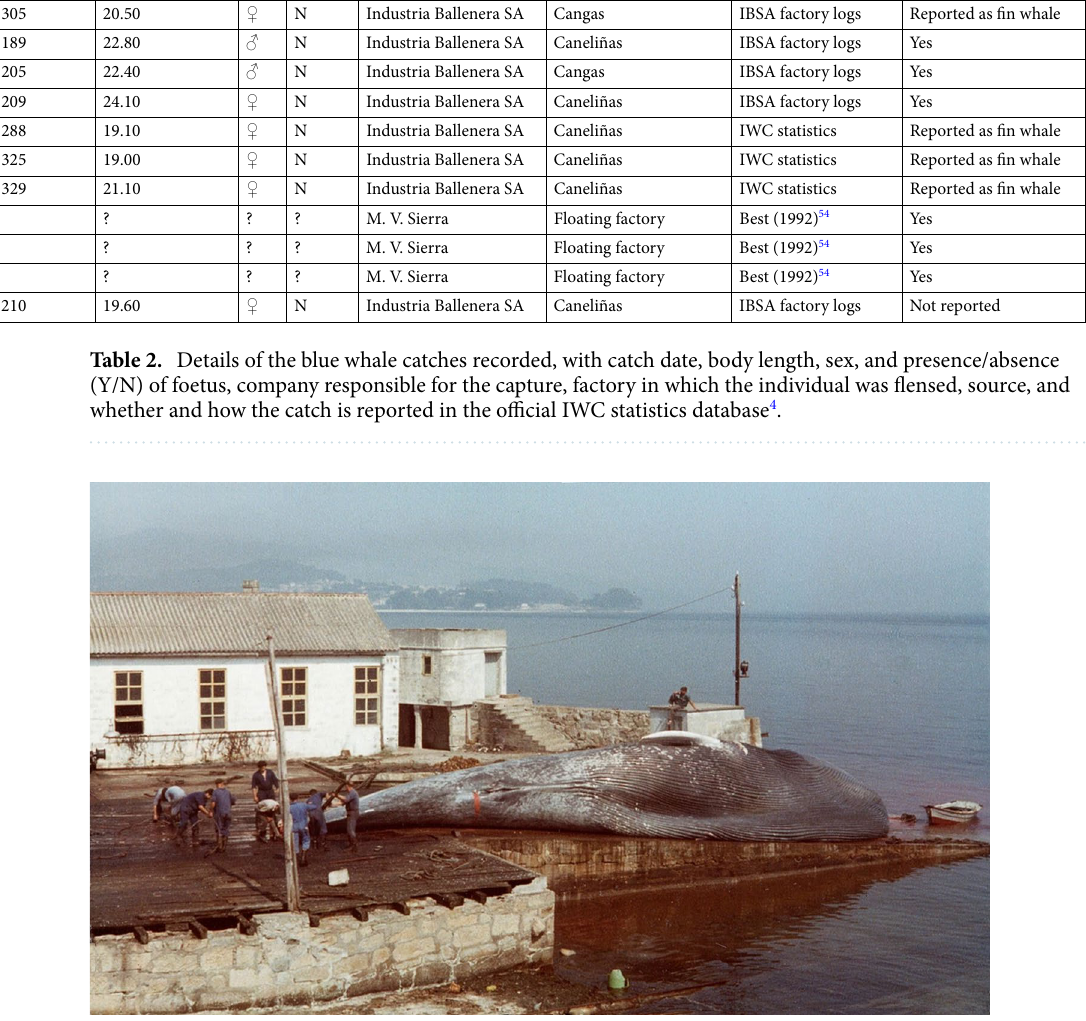
Figure 2. The 22,40 m long blue whale caught by the catcher boat IBSA DOS on 24 July, 1978, and brought to the Cangas (Balea) land factory for flensing.